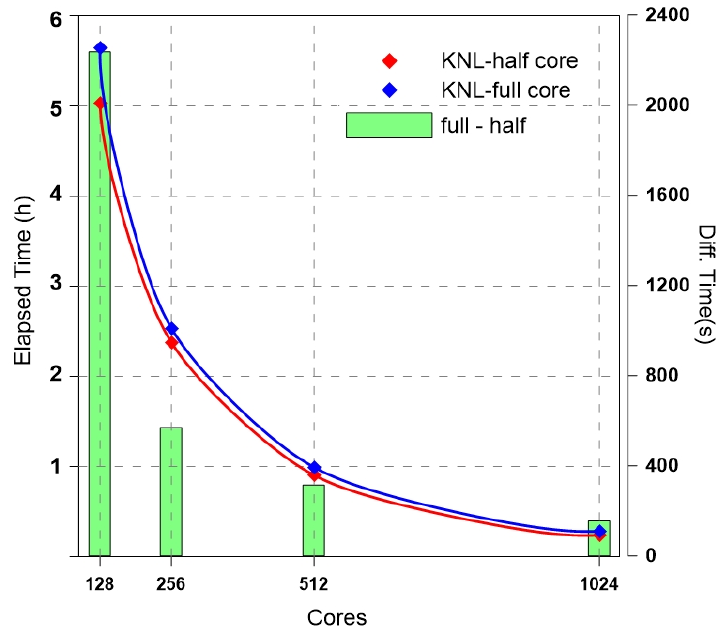
Figure 8. WRF-LES performances with respect to the number of cores per node in the KNL system for the real experiment (blue line: 64 cores, red line: 32 cores).